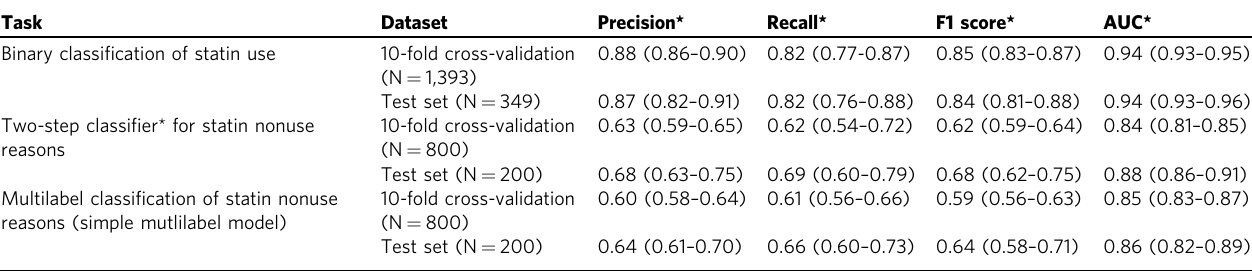
* The two-step classi fi er represents the predicted probabilities of multiple classi fi ers (each reason for statin nonuse versus others) reconciled by a Random Forest. ASCVD atherosclerotic cardiovascular disease, NLP natural language